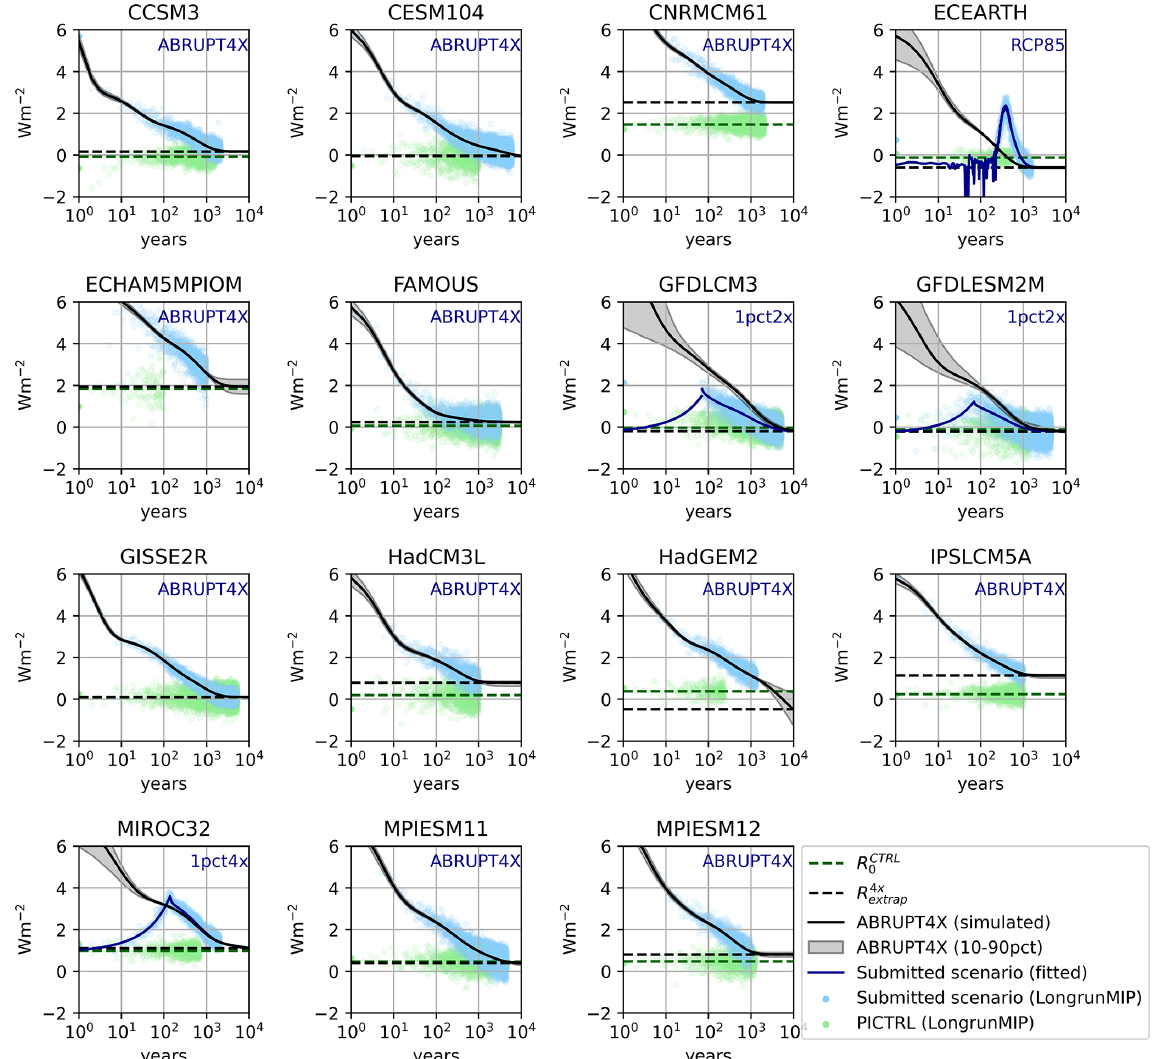
Figure 2. Top-of-atmosphere net radiative imbalance plotted as a function of time (log scale) for the members of the LongRunMIP ensemble. Dashed green line shows the control radiative imbalance ( R CTRL ), while dashed black line shows the predicted ABRUPT4X radiative 0 imbalance ( R 4 x extrap ). Semi-transparent blue and green points show annual mean upgoing net radiative flux from PICTRL and the submitted simulation (printed in blue text), respectively. Black line shows the simulated response to ABRUPT4X for the multi-timescale model, while shaded gray regions and thin lines show the 10th and 90th percentiles of the fitted ensemble projections for ABRUPT4X. If the submitted simulation was not ABRUPT4X, the thick blue line shows the MCMC posterior median TOA time series for the submitted simulation using the chosen multi-timescale model (see Table